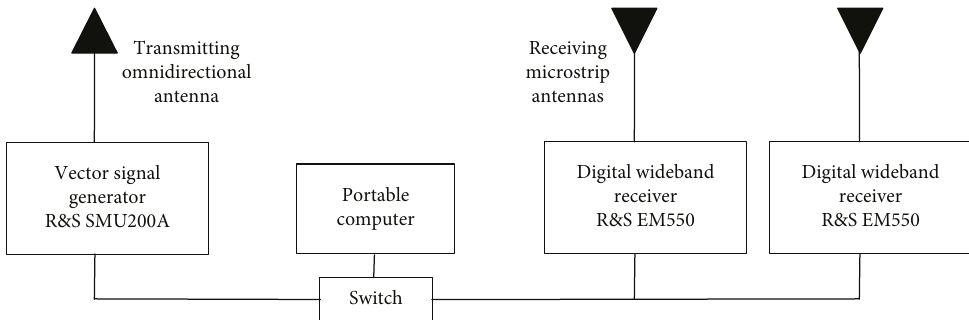
Figure 1: Measurement stand for space diversity investigations.